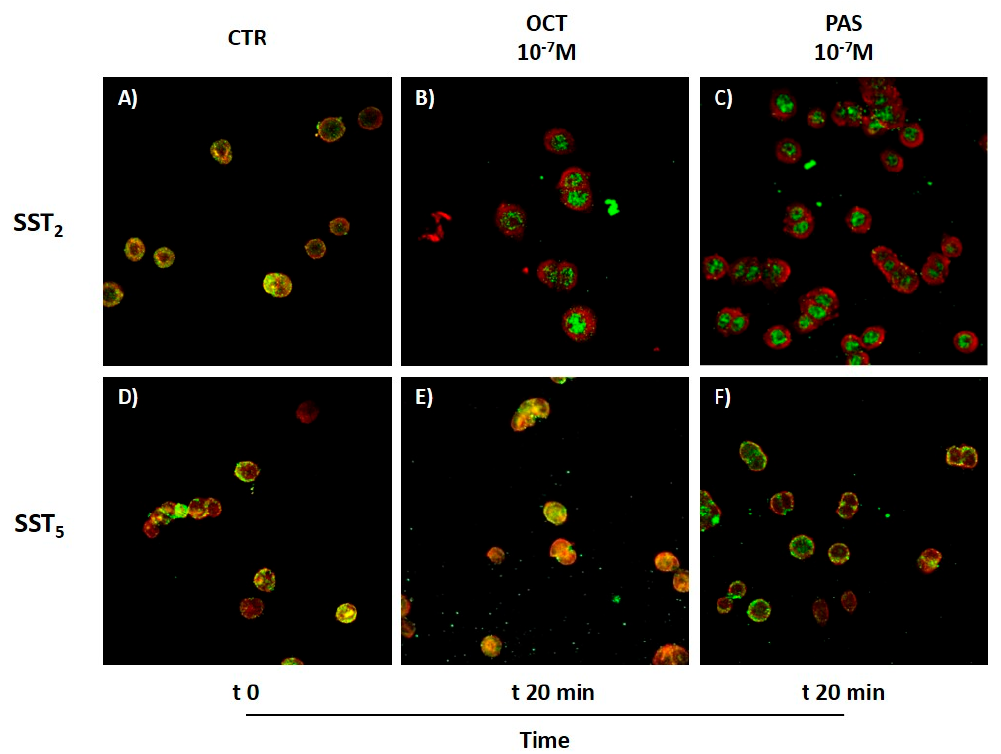
Figure 6. Effect of OCT and PAS treatment (10 − 7 M for 20 min) on SST 2 and SST 5 internalization in GH4C1 cells. Red fluorescence, DiI-stained cell membrane; green fluorescence, SST. (CTR, control; OCT, octreotide; PAS, pasireotide). Magnifi- cation: 40X.